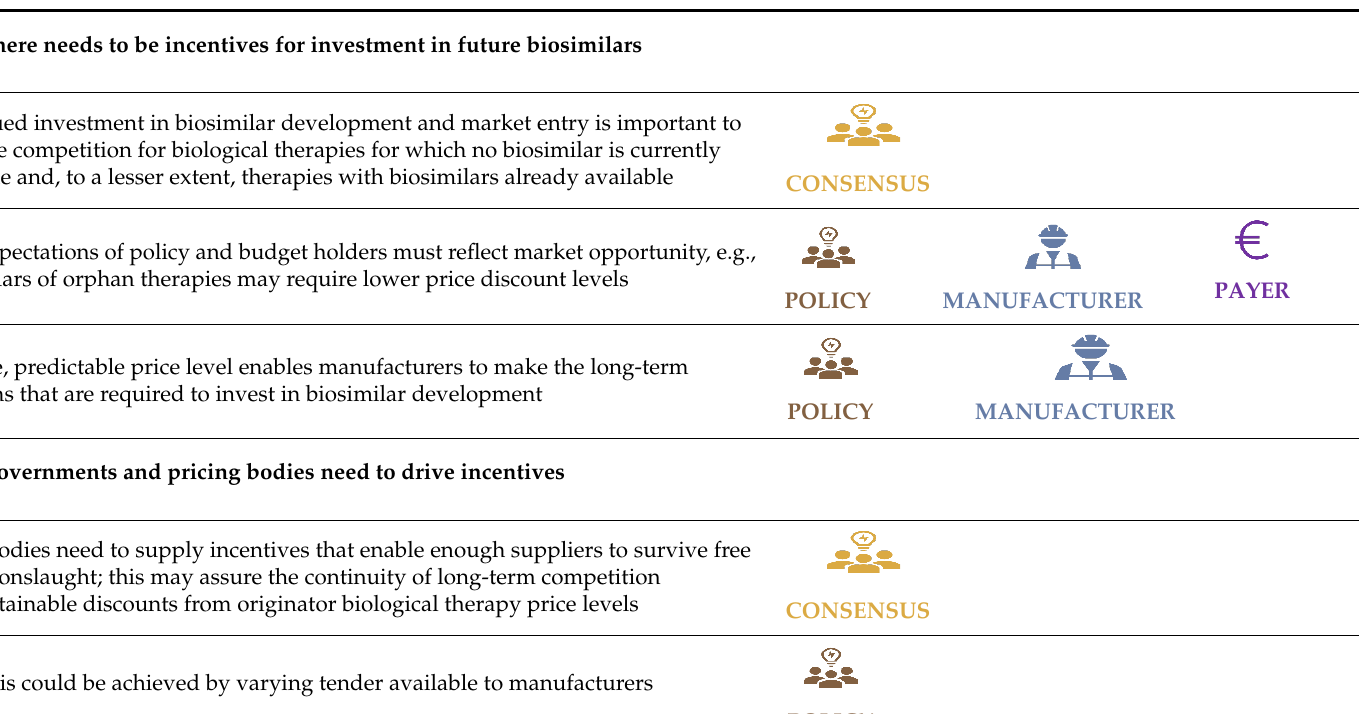
Table 2. Consensus on drivers and risks to biosimilar market sustainability (competition and incentives). Table 2. Cont.